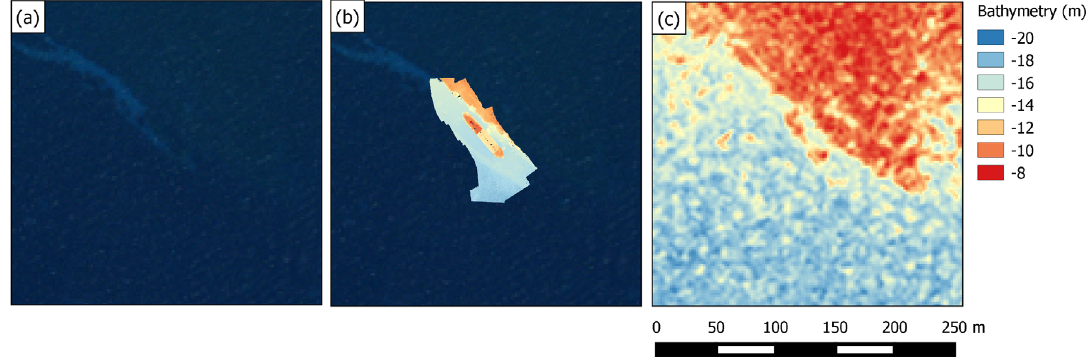
Figure 10: Overview of Elphis I bathymetry maps: (a) true color composite WorldView2 image; (b) sonar-derived bathymetry; (c) satellite-derived bathymetry.